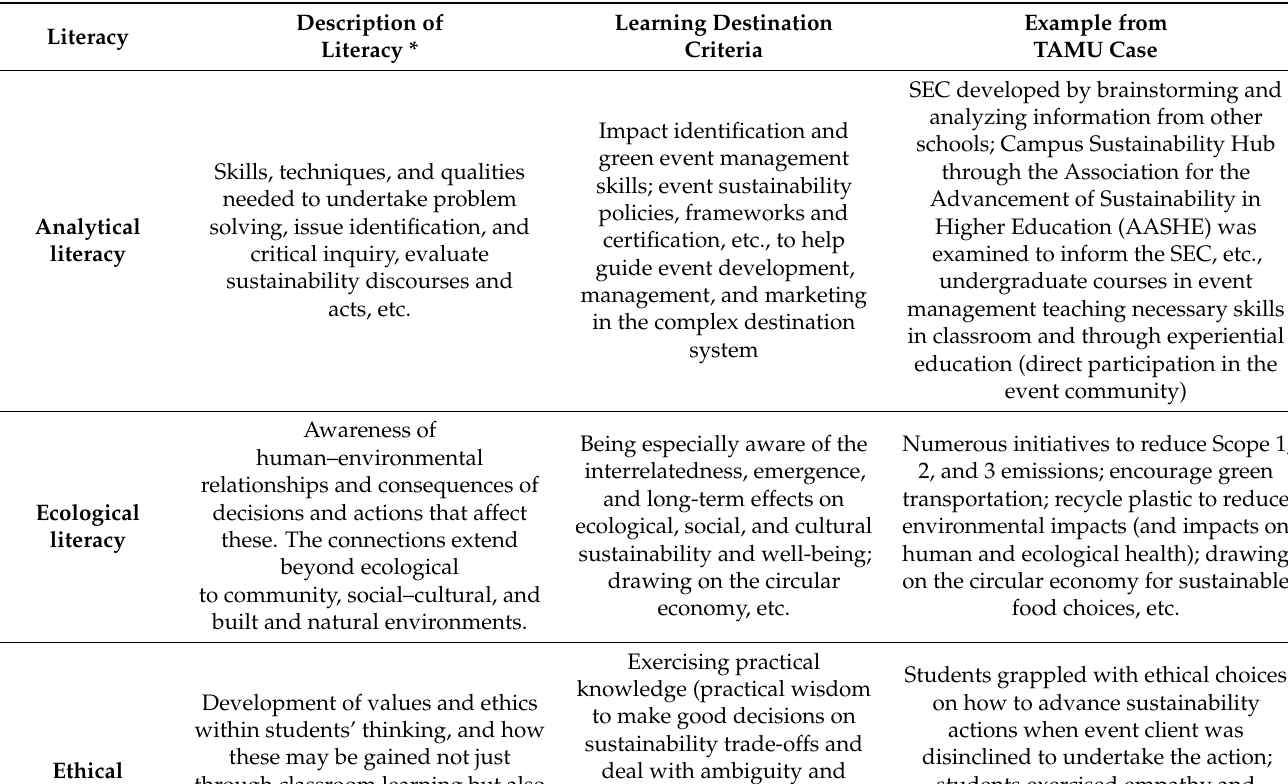
Table 2. Key literacies and criteria of learning destinations striving for resilience and sustainable event management, as well as examples from the TAMU